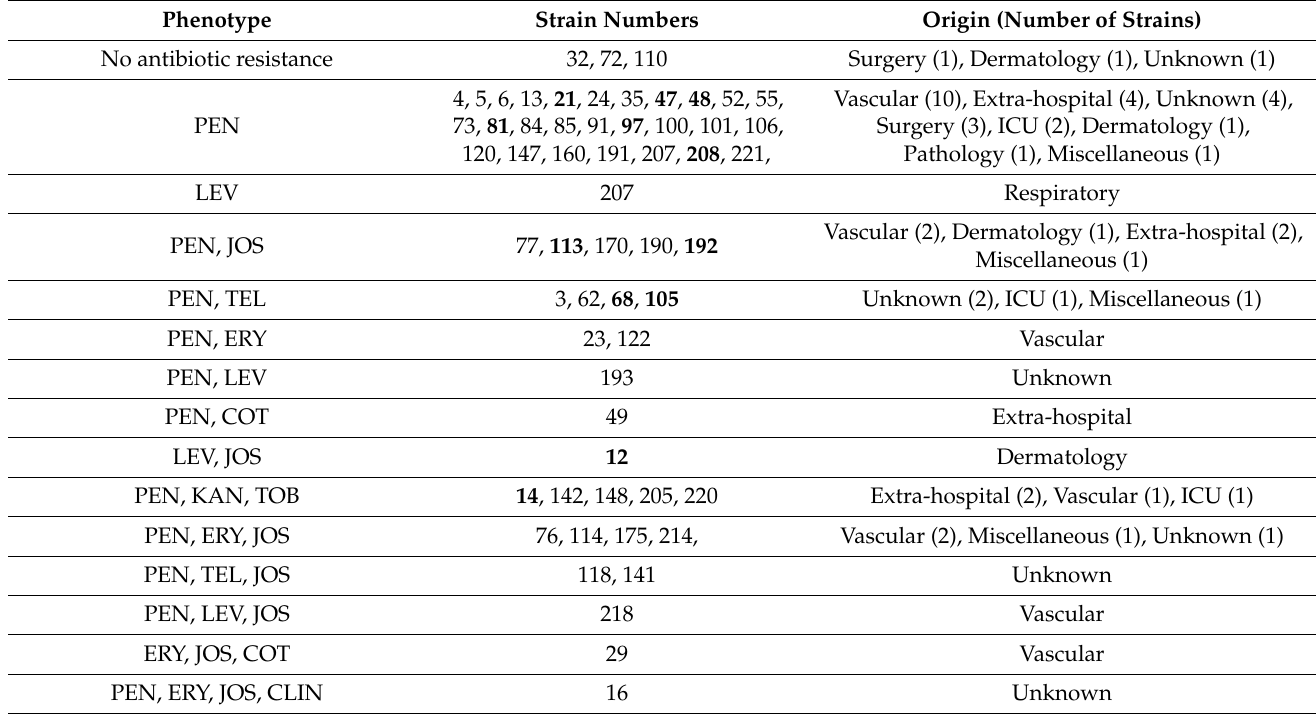
Table 1. Antibiotic-resistant phenotypes for the different isolates. In bold, the strains selected for further analysis.